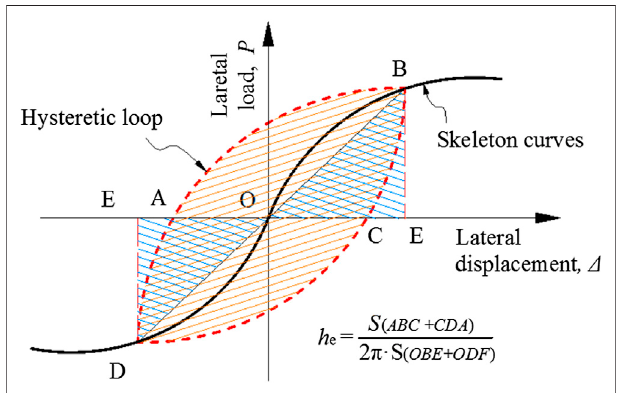
FIGURE 9 | Calculation diagram of h e .